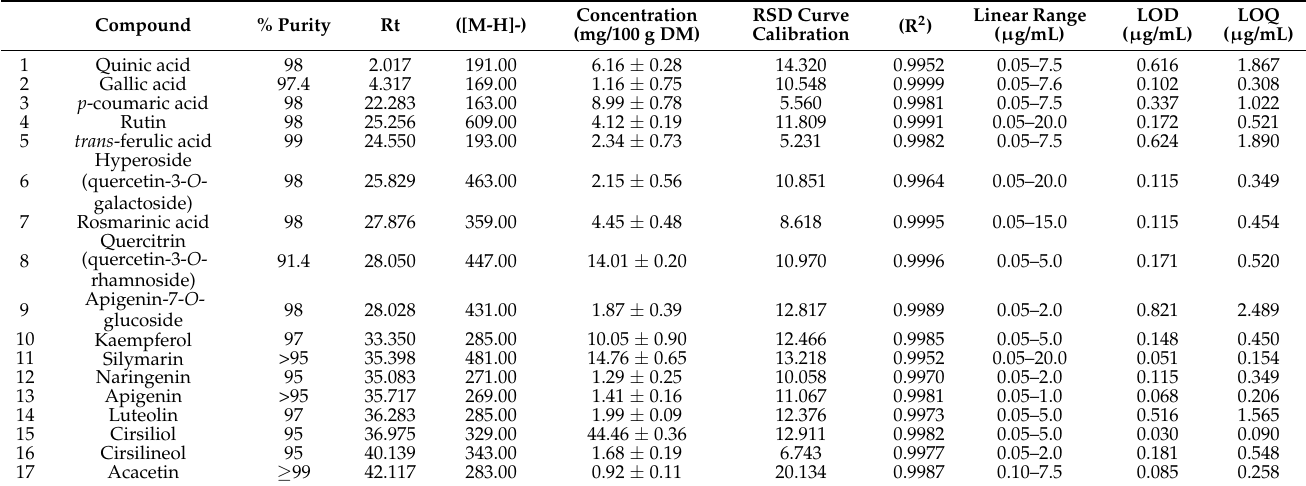
Table 1. Phytochemicals identified in the extract of A. gombiformis